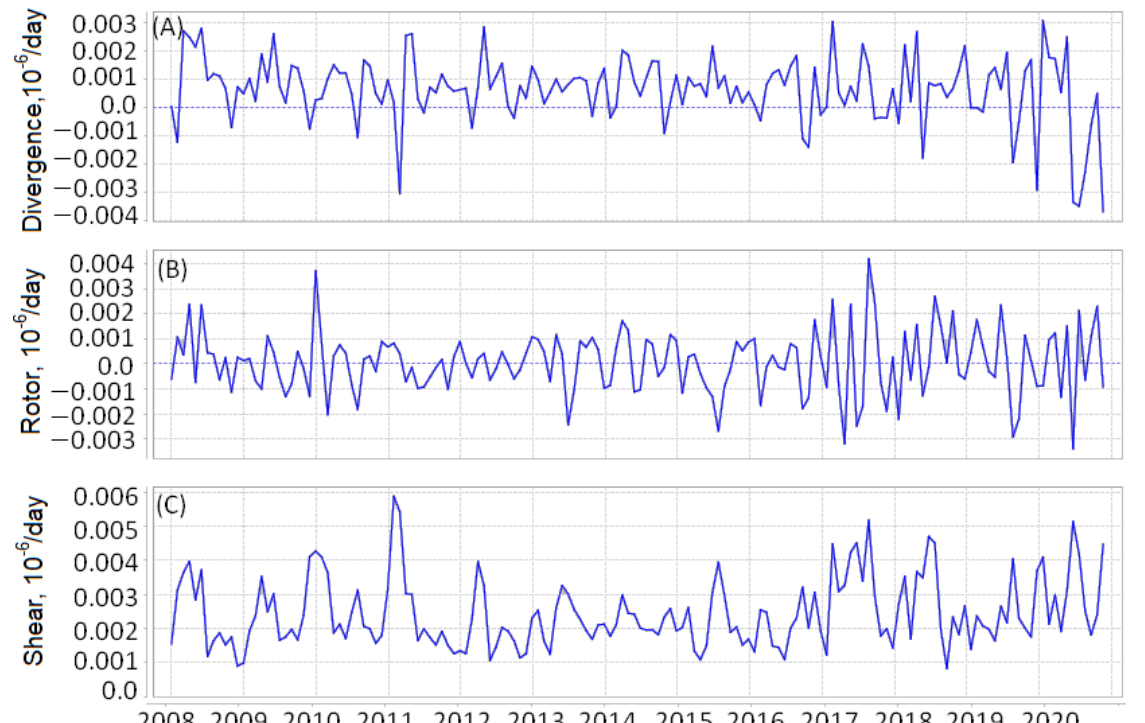
Figure 9. California. Time series at point 39.49 ◦ N and 123.2 ◦ W. ( A ) The divergence field F 1 (10 − 6 /day); ( B ) the rotor field F 2 (10 − 6 /day); ( C ) the shear field F 3 (10 − 6